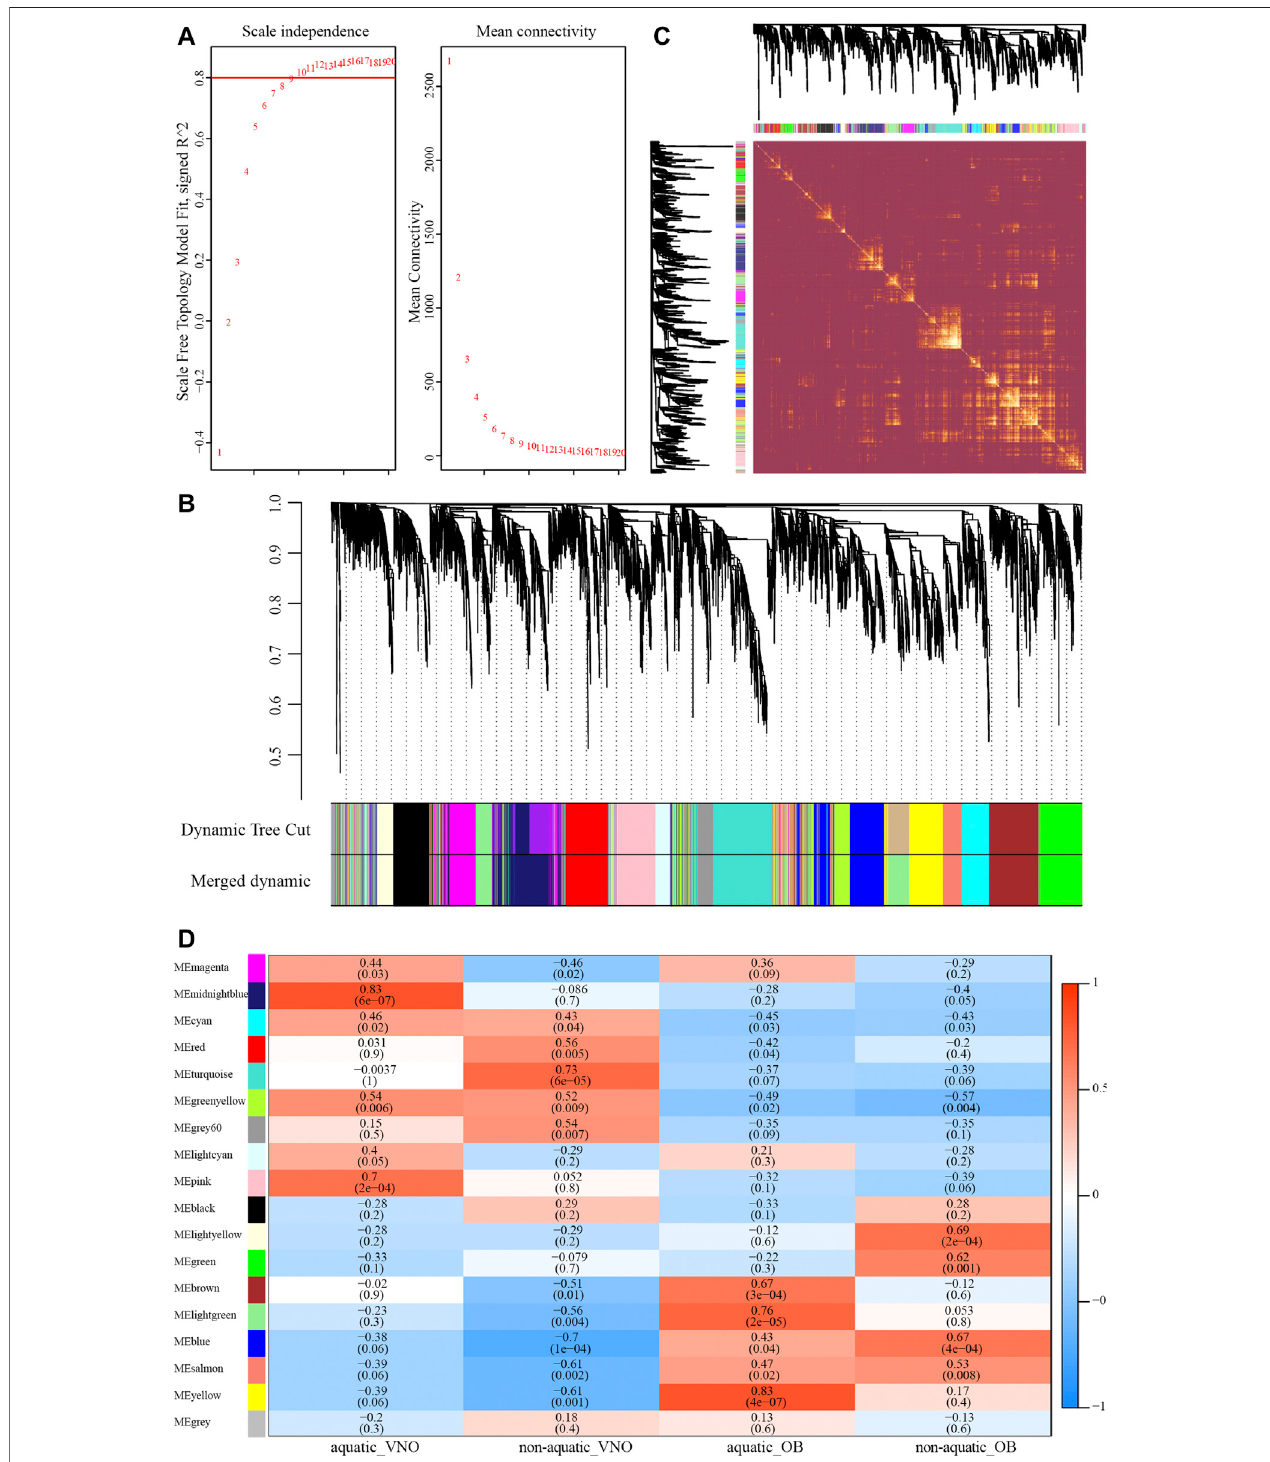
FIGURE4| Construction oftheweightedgeneco-expressionnetwork(WGCNA). (A) Analysisofsoft-thresholdingpowers basedonscaleindependence(left)and mean connectivity (right). (B) The cluster dendrogram of orthologous genes. Each row corresponds to a module eigengene. (C) Network heatmap plot of orthologous genes. (D) Module-traits relationships identi fi ed by WGCNA. The color and the number (above) of each cell indicate the correlation and the numbers in parentheses represent p -value.